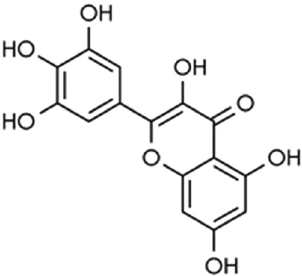
Figure 7: Flavonoid ( Source Figueirinha and Cotas in Cotas et al., 2020